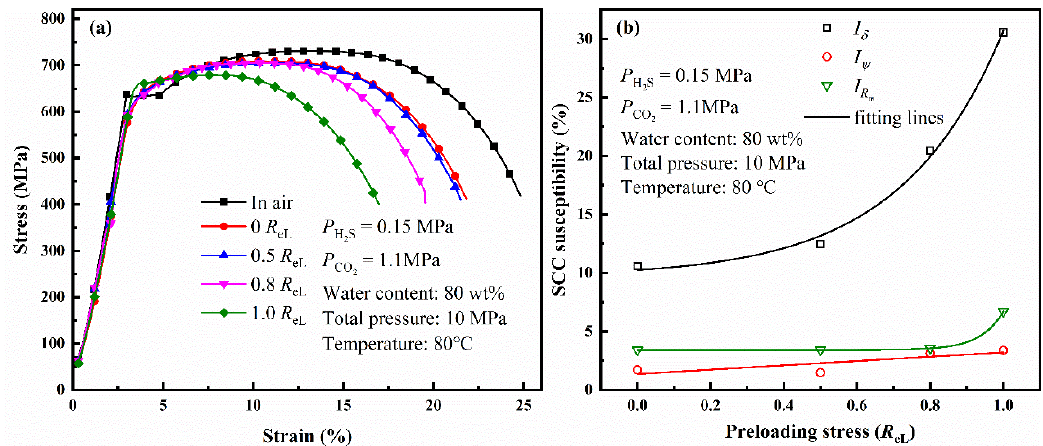
Figure 7. Corrosion rate of L80 steel with different preloading stresses obtained from immersion test.